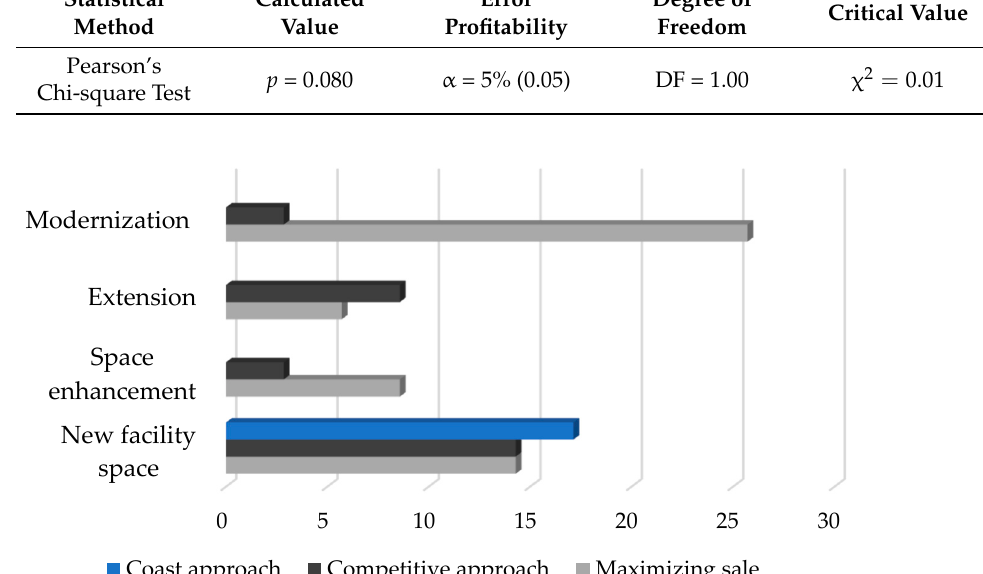
Figure 2. Relationship between pricing and capital use (cumulative number). Source: Own processing.